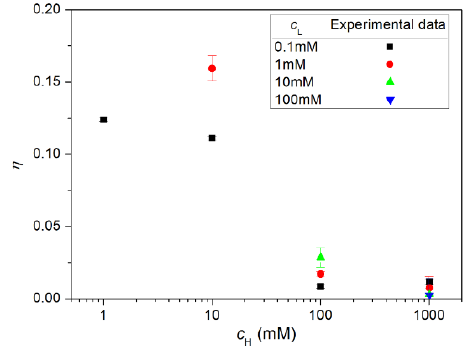
Figure 12. Energy conversion efficiency for various concentrations of NaCl solutions.